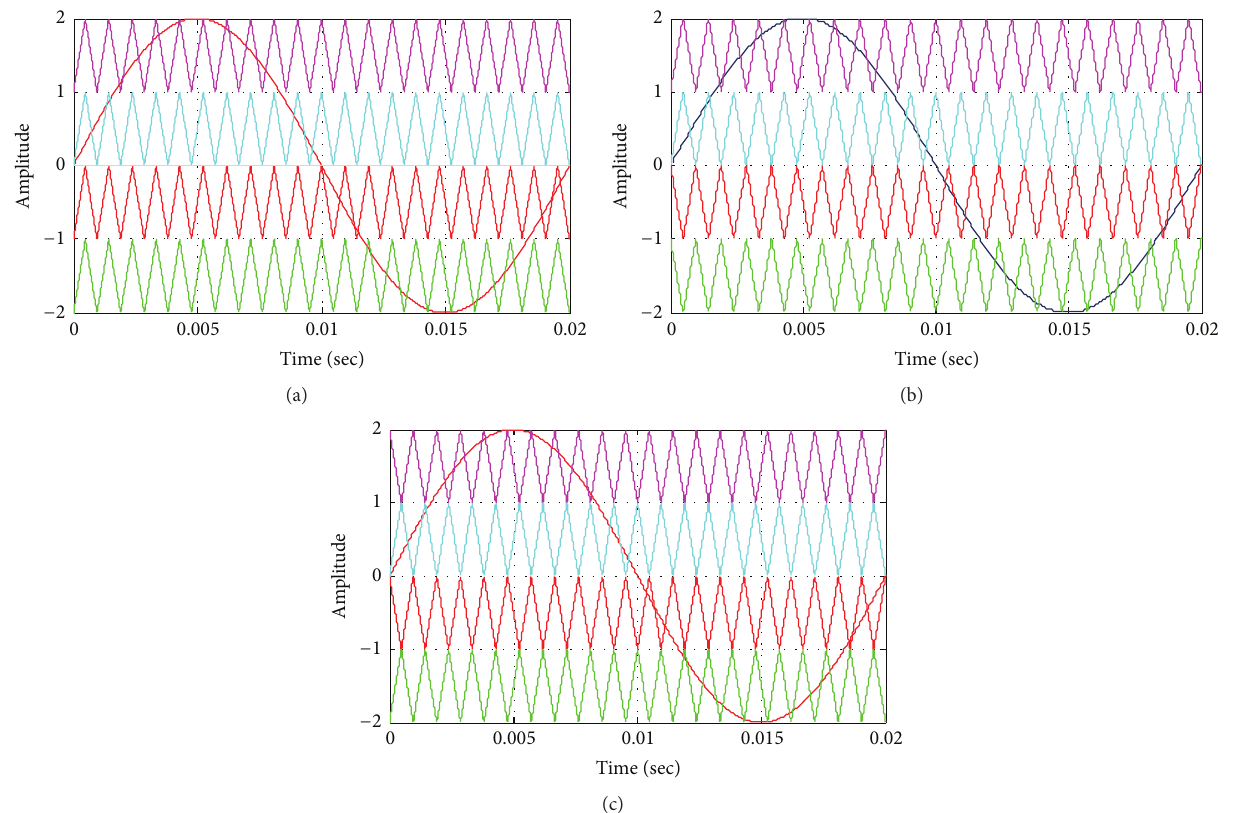
Figure 1: Carrier wave and modulating waveform: (a) PD, (b) POD, and (c)